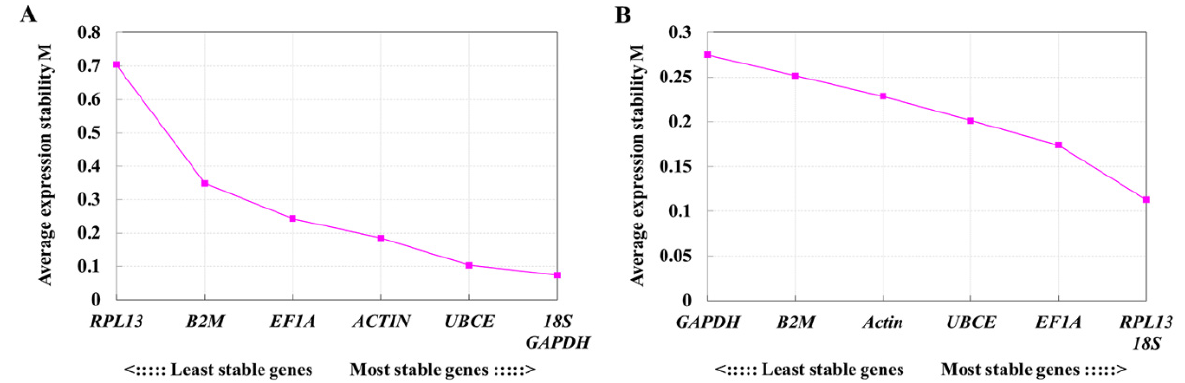
Figure 1. The expression stability of housekeeping gene candidates in GPS ( A ) and GPHK cells ( B ) under normal conditions assessed by geNorm. Based on the C t value from qRT-PCR, geNorm software was used to analyze the stability of reference genes (M). The most stable reference genes are those who possessed the smallest M value.